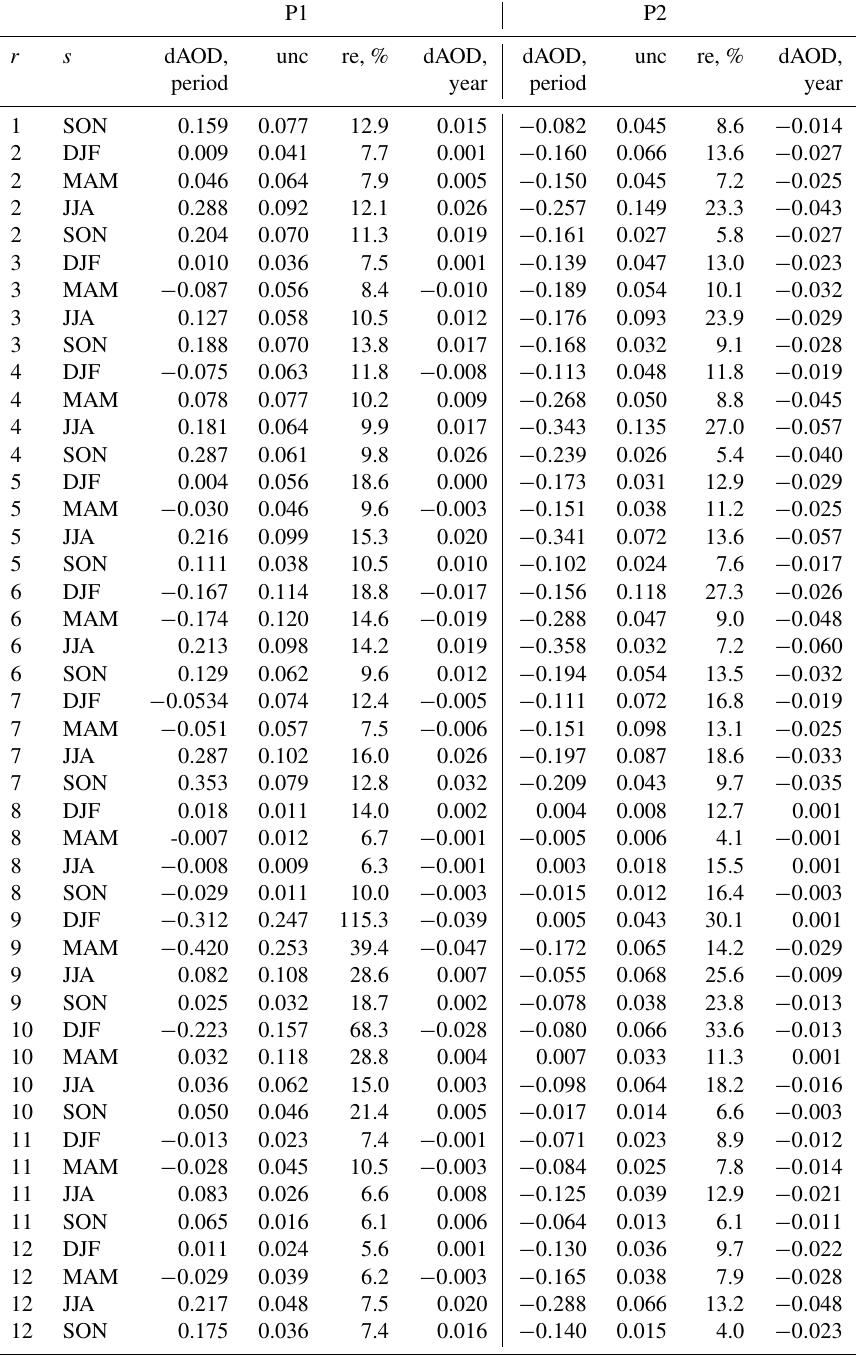
Table A3. AOD tendency (dAOD) per period and year, uncertainty (unc) and relative error (re, %) for the seasonally combined AOD time series for two periods: P1 (1995–2006) and P2 (2011–2017) for the different regions ( r , where region 11 is mainland China and region 12